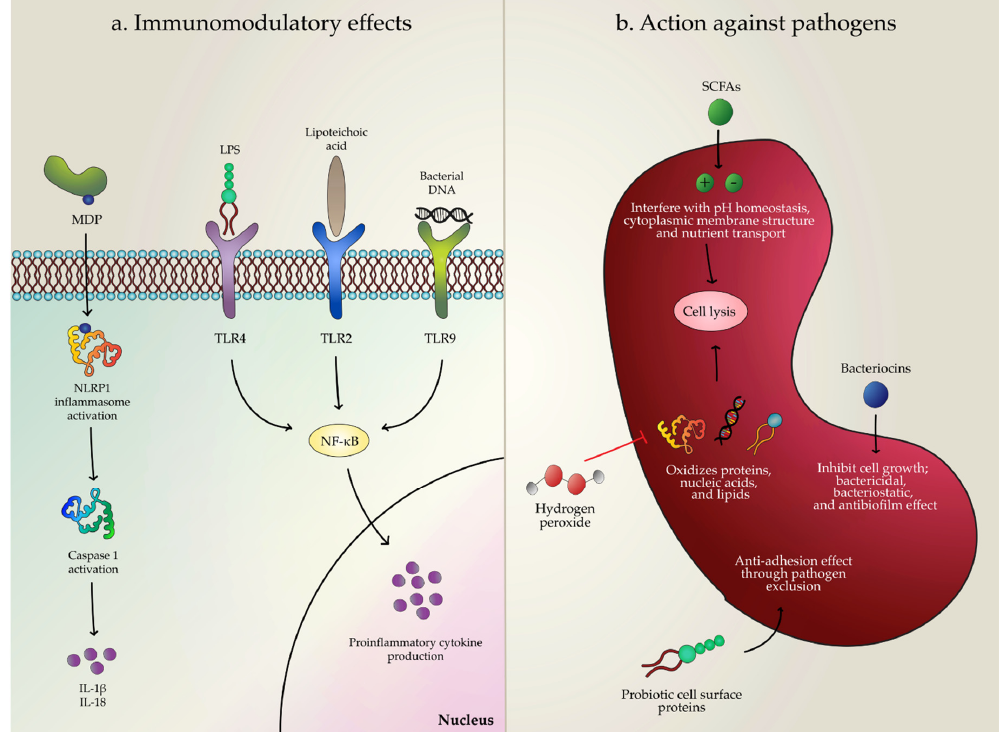
Figure 1. Potential mechanisms of action of postbiotics. ( a ) Modulation of the host’s immune response. ( b ) Acting on the pathogen. MDP: muramyl dipeptide; NLRP1: NACHT [NAIP (neuronal apoptosis inhibitory protein), CIITA (MHC class II transcription activator), HET-E (incompatibility locus protein from Podospora anserina ) and TP1 (telomerase-associated protein)] domain-, leucine-rich